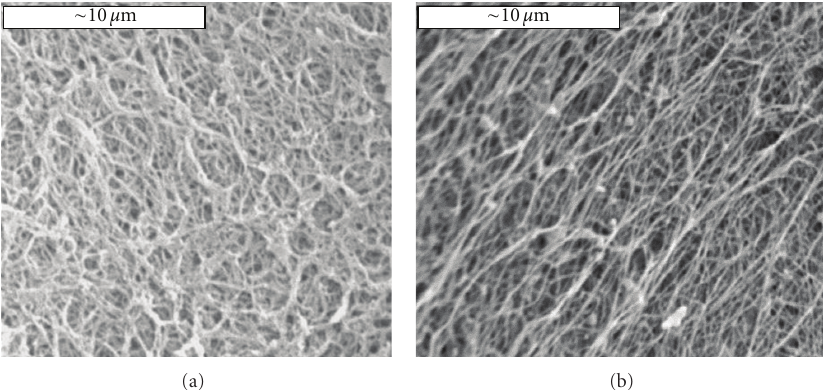
Figure 6: Scanning electron microscopy (SEM) images of (a) nonaligned and (b) aligned 0.03% GP crosslinked collagen sca ff olds. All the scale bars represent 10 μ m.